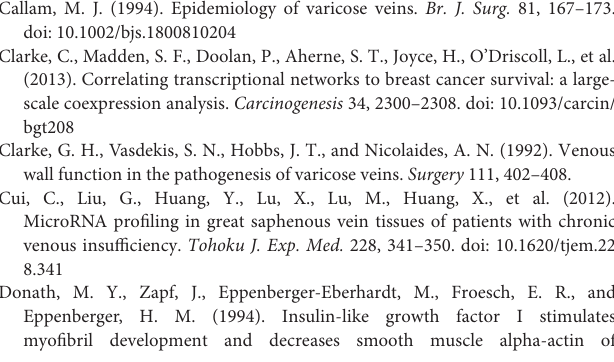
FIGURE S1 | Gene functional analysis of DE genes. FIGURE S2 | Gene functional analysis of module yellow genes. DATA SHEET S1 | Differentially expressed genes of VV and GSV from CAGB